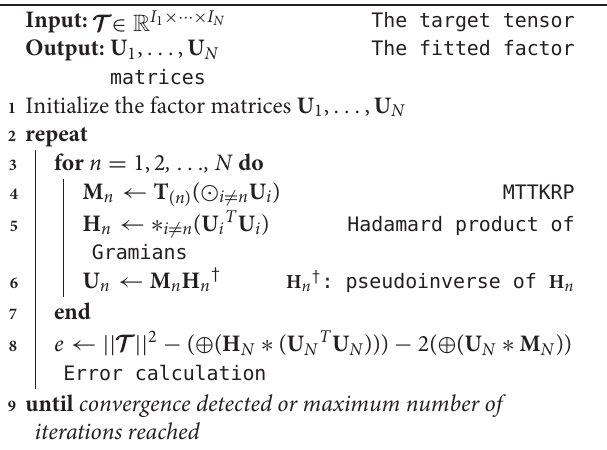
Algorithm 1: CP-ALS: Alternating least squares method for CP